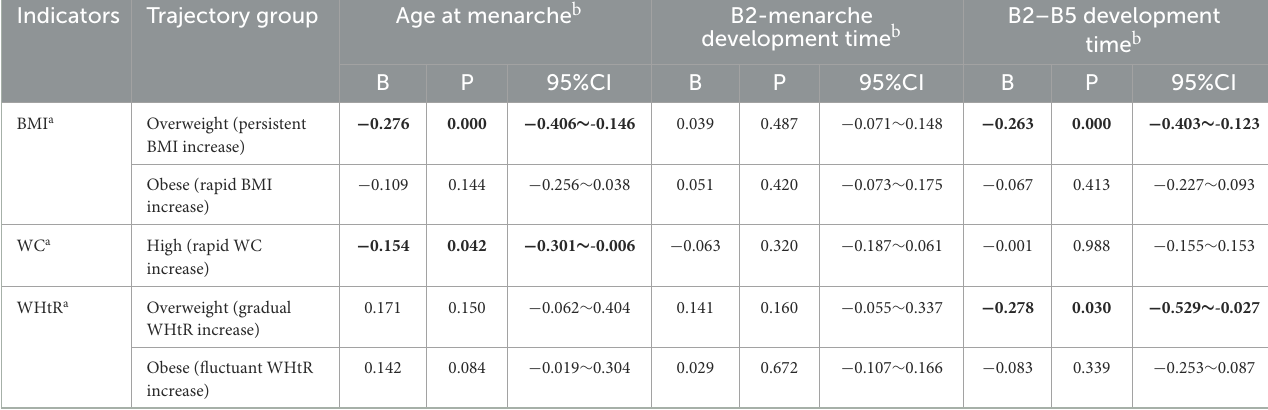
TABLE 6 The relationship between the trajectory of obesity indicators and age at menarche and pubertal tempo before menarche. Indicators